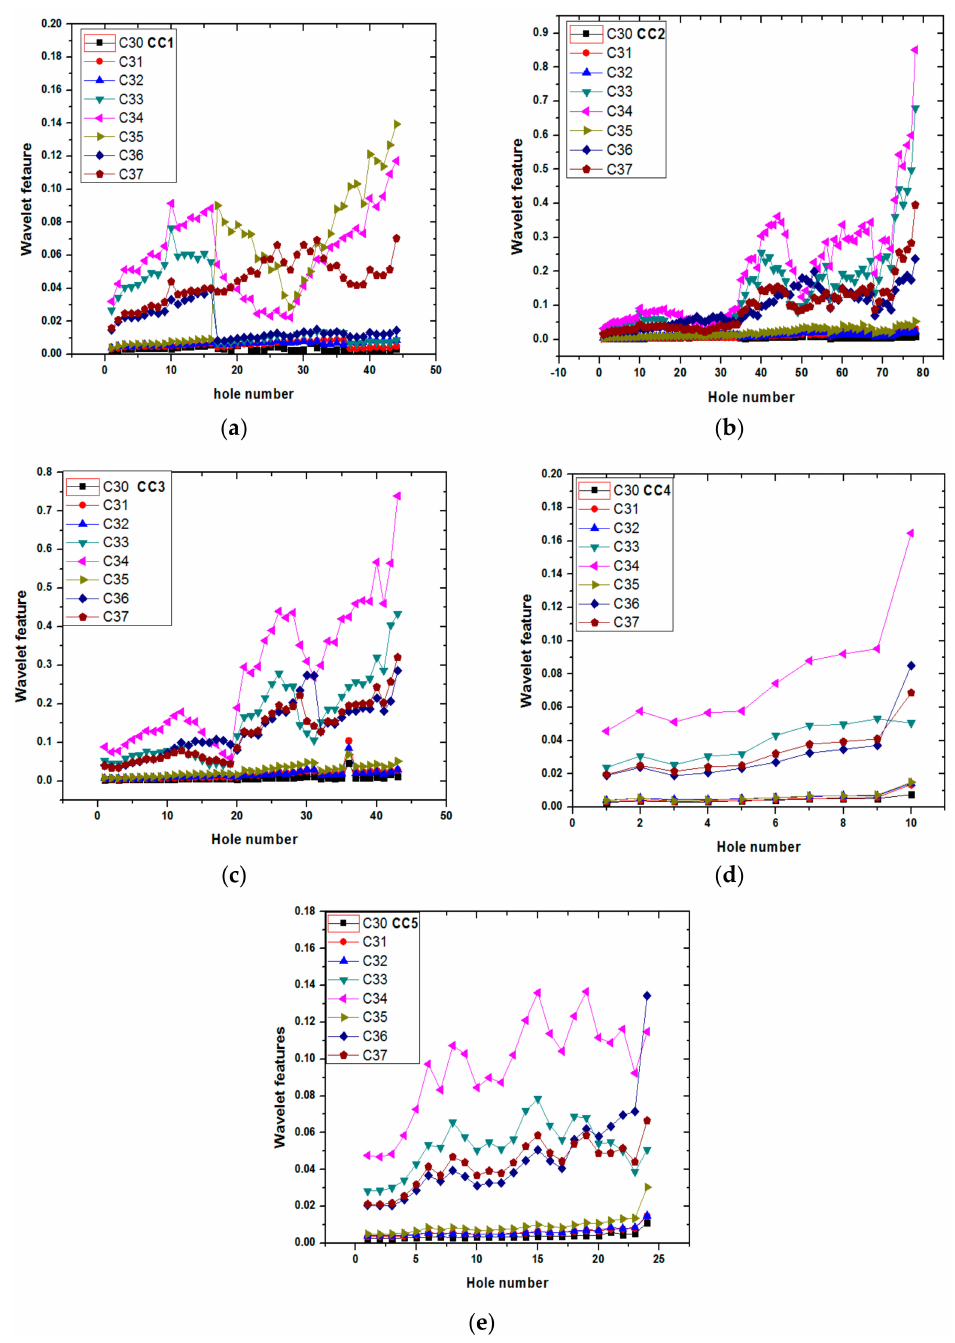
Figure 4. Wavelet packet features for di ff erent cutting conditions ( a ) CC1; ( b ) CC2; ( c ) CC3; ( d ) CC4; ( e ) CC5 from 1 st hole to last hole before drill